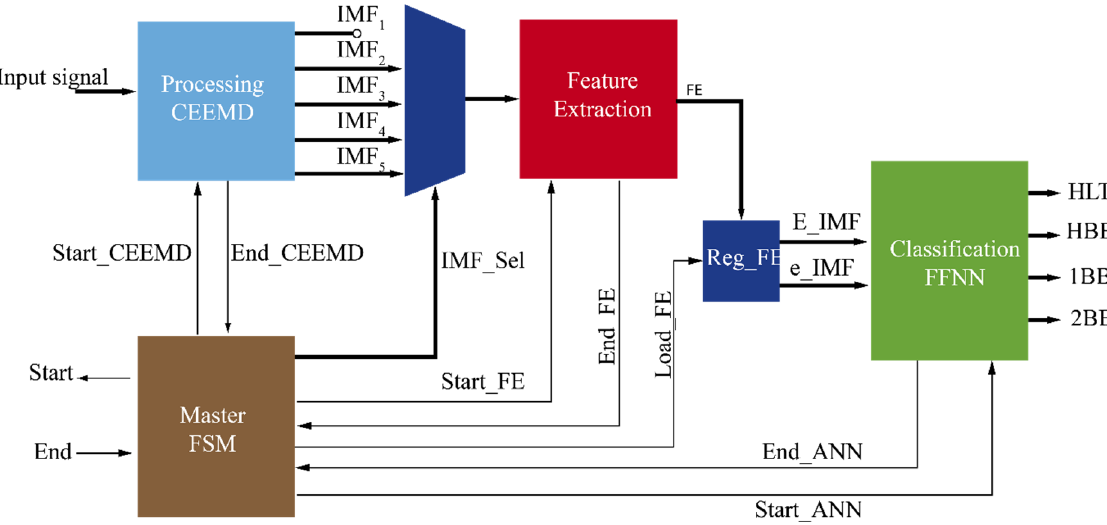
Figure 5. FPGA processor. Figure 5. FPGA